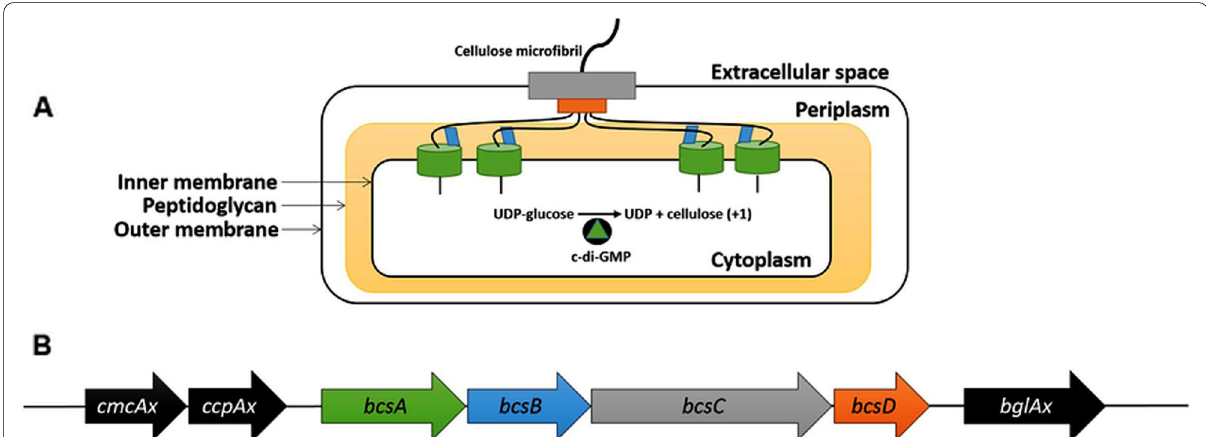
Fig. 1 Genetic organization of bcs operon [3]. A When bcs A ( green ) is activated by c‑di‑GMP, it incorporates glucose units into a cellulose chain in the cytoplasm using UDP glucose as a substrate. BcsB ( blue ) guides the glucan chain through the periplasm; bcs D ( orange ) crystallizes four glucan chains in the periplasm, and finally, bcs C ( gray ) exports the BC micro‑fibrils into the extracellular space. B The genetic organization of the bcs operon encoding the bacterial cellulose synthase complex, with regulatory cmcax , ccpAx genes upstream bgIAx gene downstream the operon. The genes in the bcs operon ( B ) are color‑matched with their protein products ( A ). This work is licensed under the Creative Commons Attribution 4.0 International License. To view a copy of this license, visit http:// creat iveco mmons. org/ licen ses/ by/4. 0/ or send a letter to Creative Commons, PO Box 1866, Mountain View, CA 94,042,